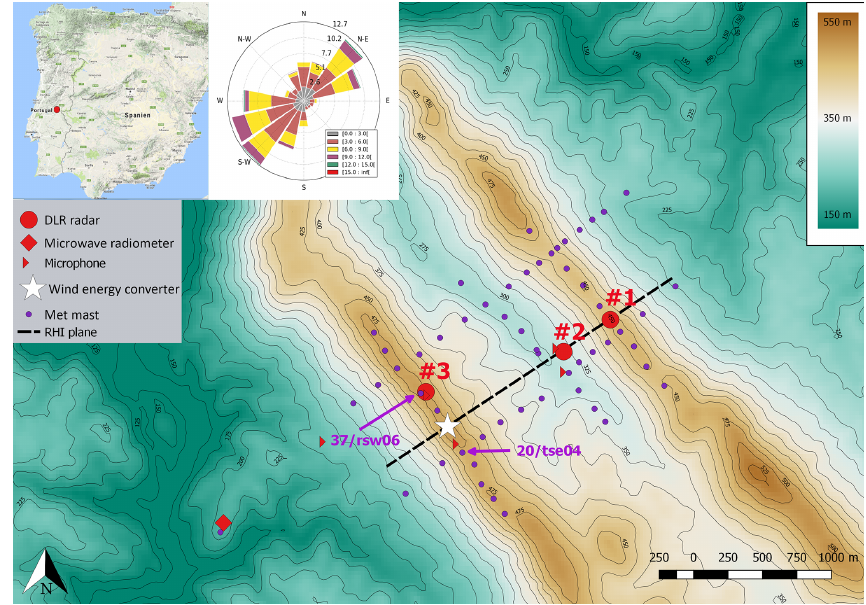
Figure 1. Map of the Perdigão site, including DLR instrumentation and meteorological mast locations. It also shows a wind rose for the sonic anemometer at 80m on tower 20/tse04 for the IOP period. The dashed black line indicates the typical RHI scanning plane.